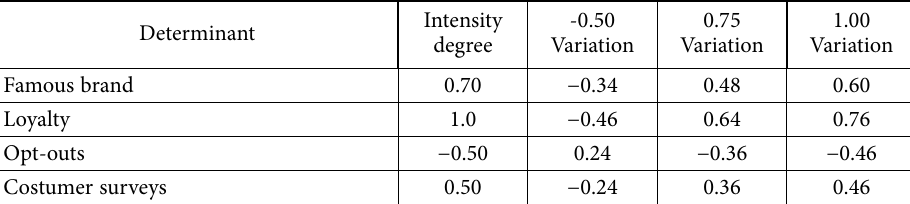
Table 7. Analysis of marketing and